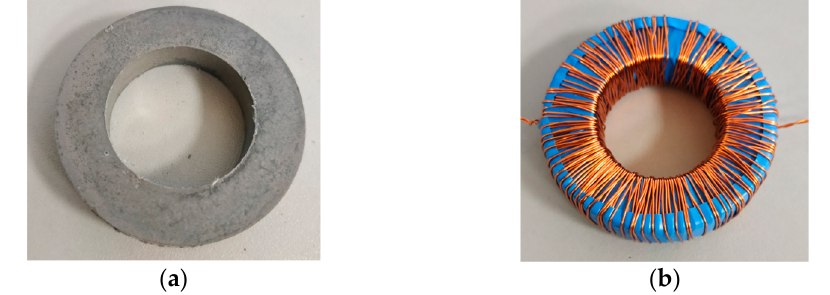
Figure 6. Examples of toroidal samples; ( a ) core, ( b ) core with winding.